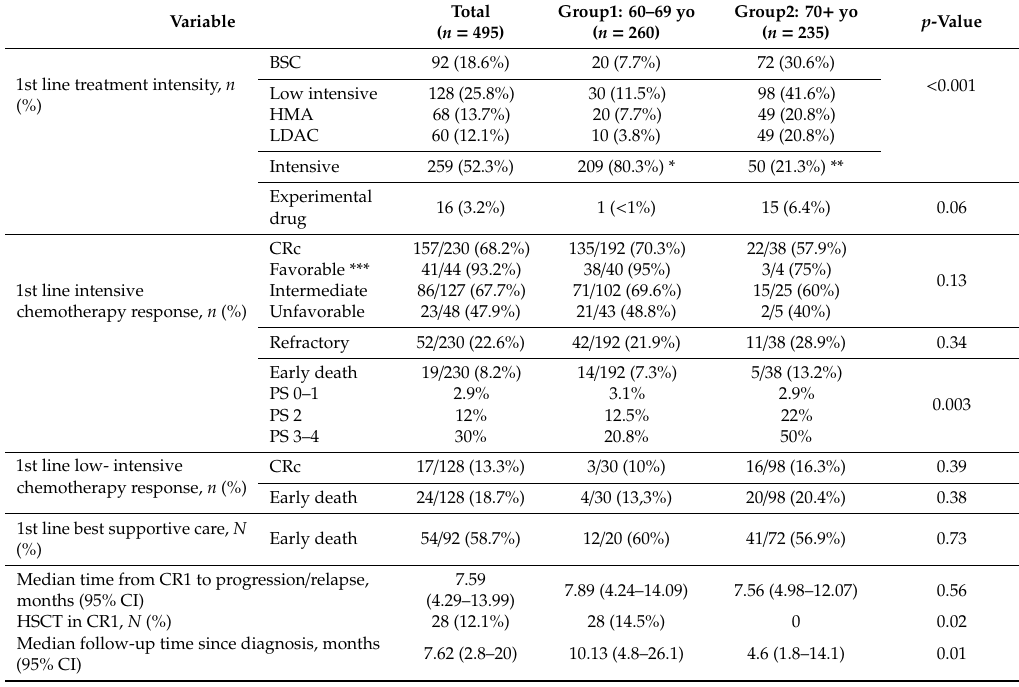
Table 2. Treatment intensity proportion among age groups and rate of response according to the initial treatment type after removing APL